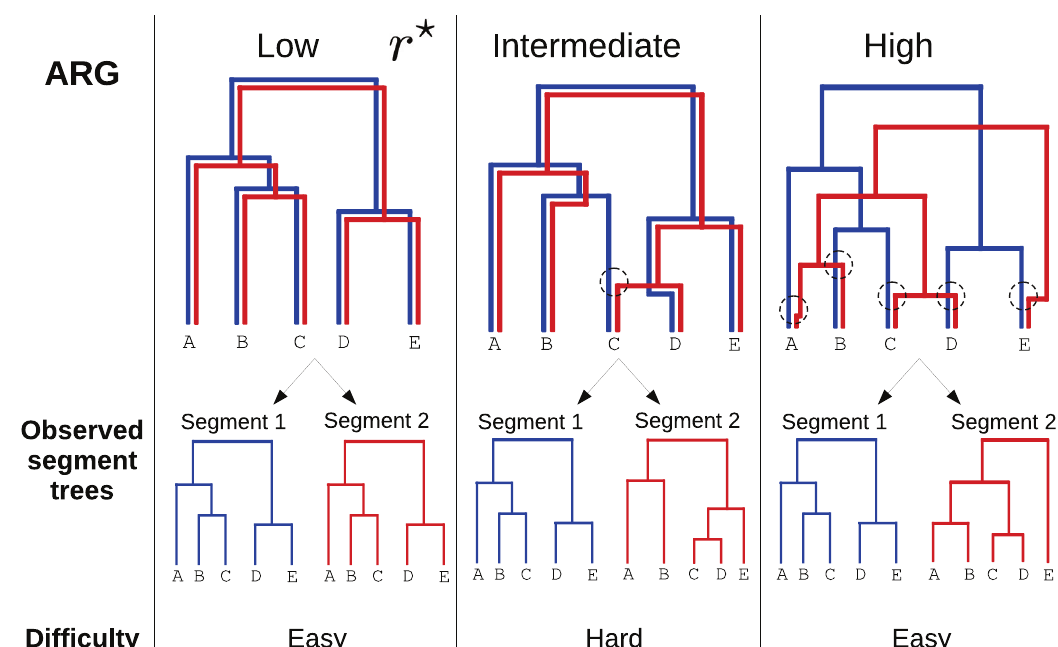
Fig 1. Example of ARGs for five sampled strains and for two segments (blue and red). Reassortments are shown as black circles in each ARG. Based on the scaled reassortment rate in the population r ? , three regimes can be identified. Left : Very low reassortment rate. Reassortments are very rare, and every strain inherits its two segments from the same parent. The ARG is equal to the gene trees, and reconstructing it is easy. Center : Intermediate reassortment rate. Some exchange of segments takes place: some strains do not inherit their segments from the same parent (here, strain C ). The segments trees have different topologies, but are still relatively similar. Inferring the position of reassortments from the gene trees is non trivial. Right : Very high reassortment rate. A reassortment takes place on every branch of the ARG before the first coalescence. The two segments have independent evolutionary histories, and the segment trees share no structure. Inference of reassortments becomes easy again.